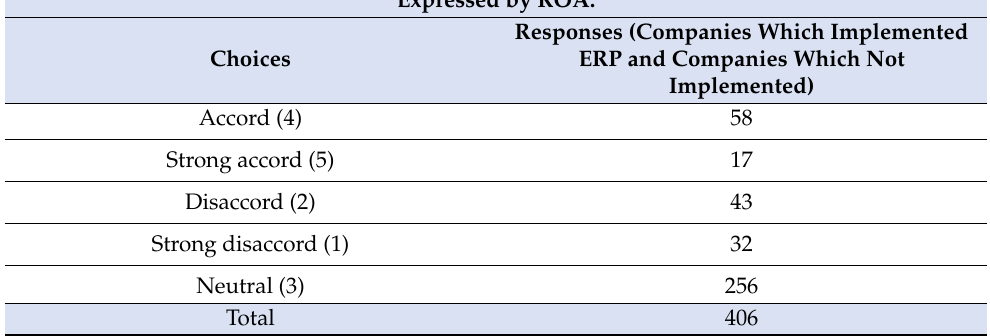
Table 3. Results of responses to questionnaire for Hypothesis 1- total respondents who filled in the